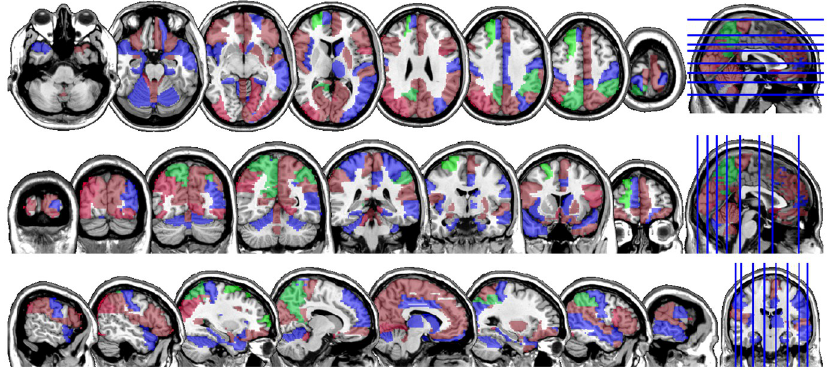
Fig 4. The multi-slice display (Axial, Coronal, Sagittal) of the regions of interests, the BOLD activities of which achieves the lowest prediction error and correlate the most with the IQ score variability in the sample when the MFG-LASSO is used. The regions associated with the IQ score are colored red, those associated with the performance IQ are blue, and the ones associated with the verbal IQ are colored